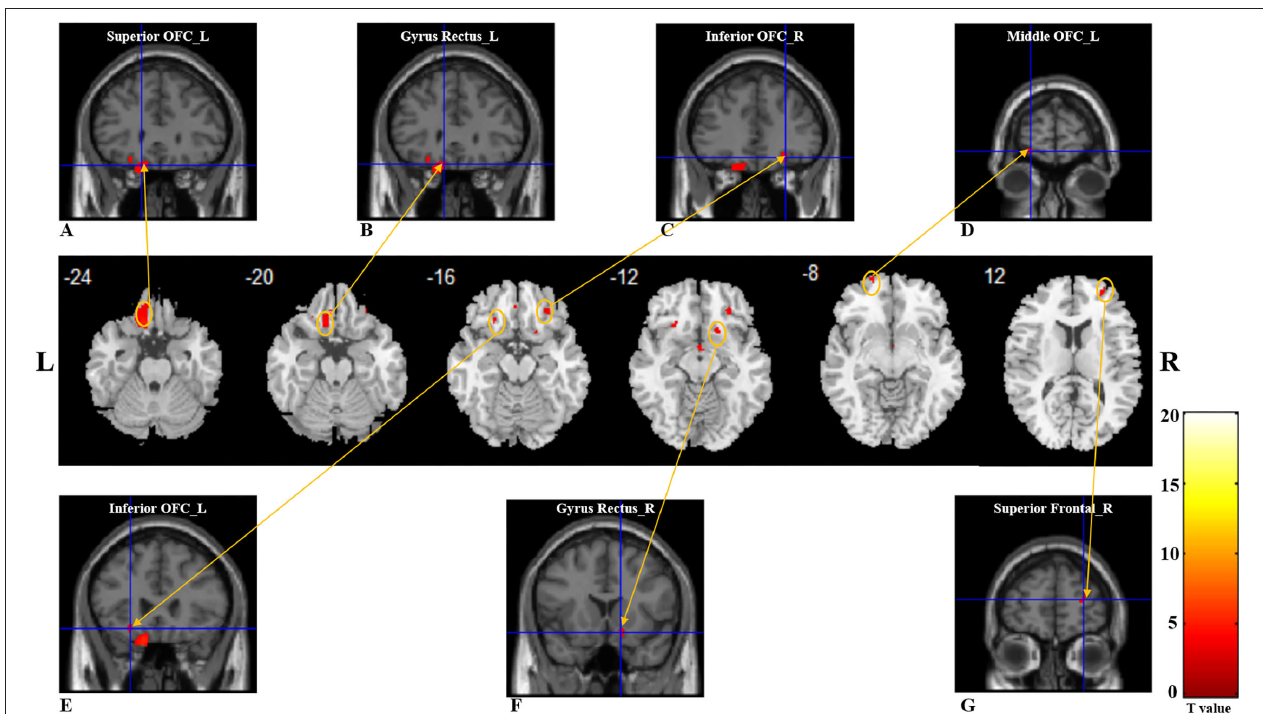
FIGURE 2 | White matter reductions in post-traumatic patients anosima compared with healthy controls. The VBM result is thresholded at P < 0.001. Whole-brain analyses with P uncorrected < 0.001, and a cluster-extent threshold applied: k ≥ 36 for the main effect t -test. (A–G) with red color represents the decreased WM volume regions in the patient group. (A) left superior OFC; (B) left gyrus rectus; (C) right inferior OFC; (D) left middle OFC; (E) left inferior OFC; (F) right gyrus rectus; (G) right superior frontal. VBM, voxel-based morphometry; L, Left; R, Right; OFC, Orbitofrontal cortex.